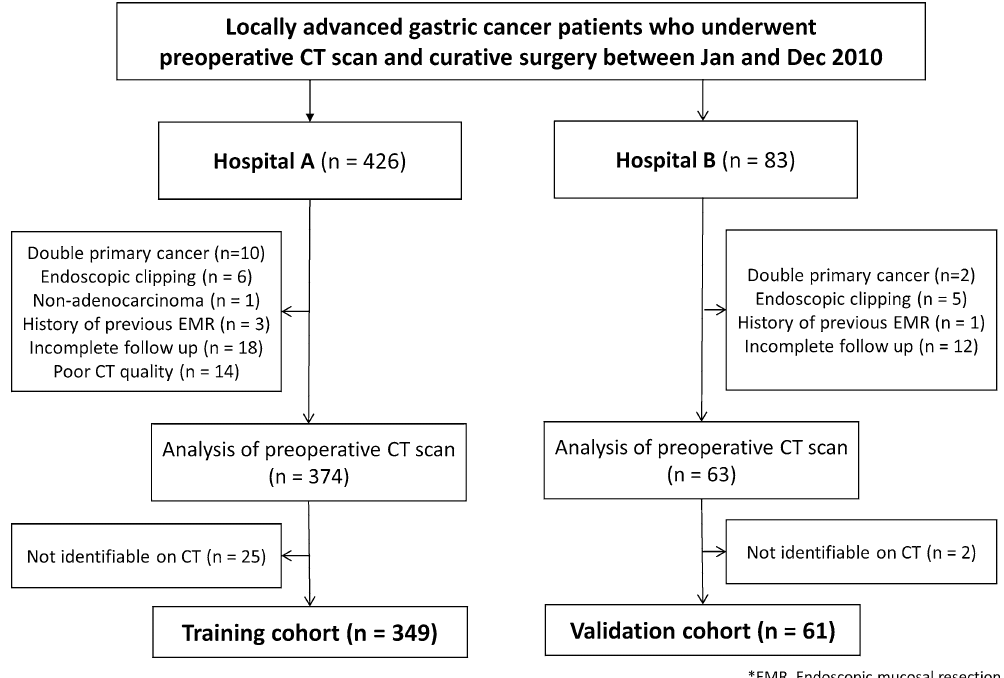
Figure 1. Flowchart for patient selection in training cohort and validation